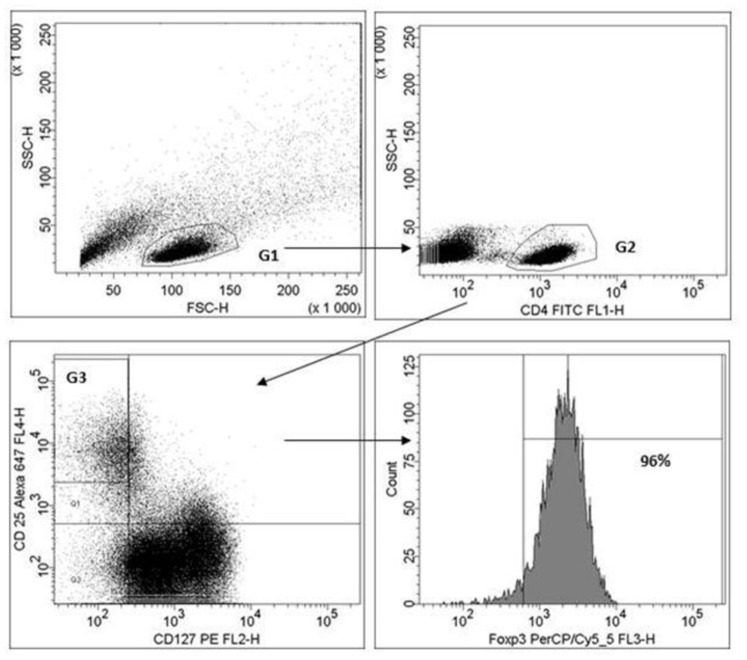
A representative example of gating CD4+CD25highCD127neg lymphocytes in flow cytometry after 5 days co-culture of Lactobacillus casei ATCC 334 and PBMC from one blood donor.First lymphocytes ( = G1) are gated in FSC-SSC plot. From lymphocyte gate CD4-positive cells are gated in G2 from which the cells expressing high intensity CD25 and no CD127 are gated to represent regulatory T cells (G3). CD4+CD25highCD127neg ( = G3) cells are shown to express FOXP3 in histogram in which the gate is placed according to isotype control.